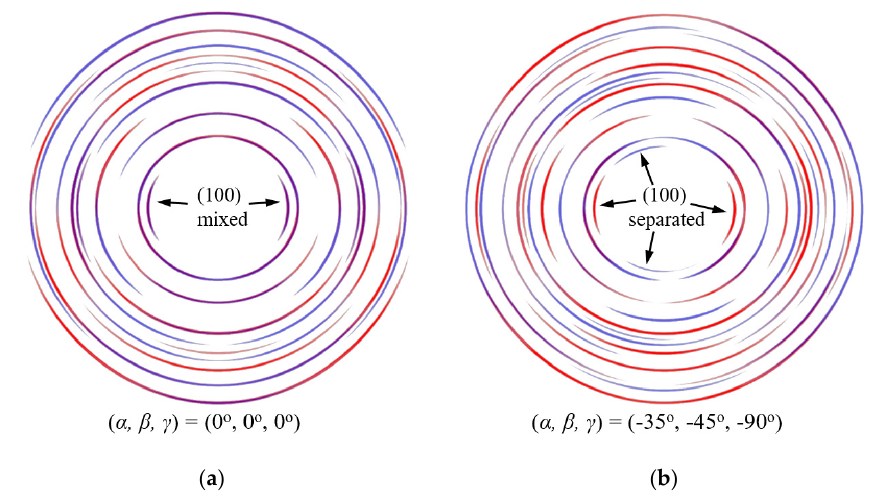
Figure 2. Debye–Scherrer rings of a textured Ti with two texture components ( ϕ 1 , Φ , ϕ 2 ) = ( 90 ◦ , ± 40 ◦ ,0 ◦ ) for two di ff erent specimen orientations. The intensities corresponding to the two di ff erent texture components are indicated by red and blue colours. Where both texture components contribute to the intensity, the colour becomes purple in the figures. ( a ) shows a specimen orientation when the contributions from both components to the (100) reflection are mixed. ( b ) shows an optimized sample orientation for which the (100) reflections can be obtained separately.